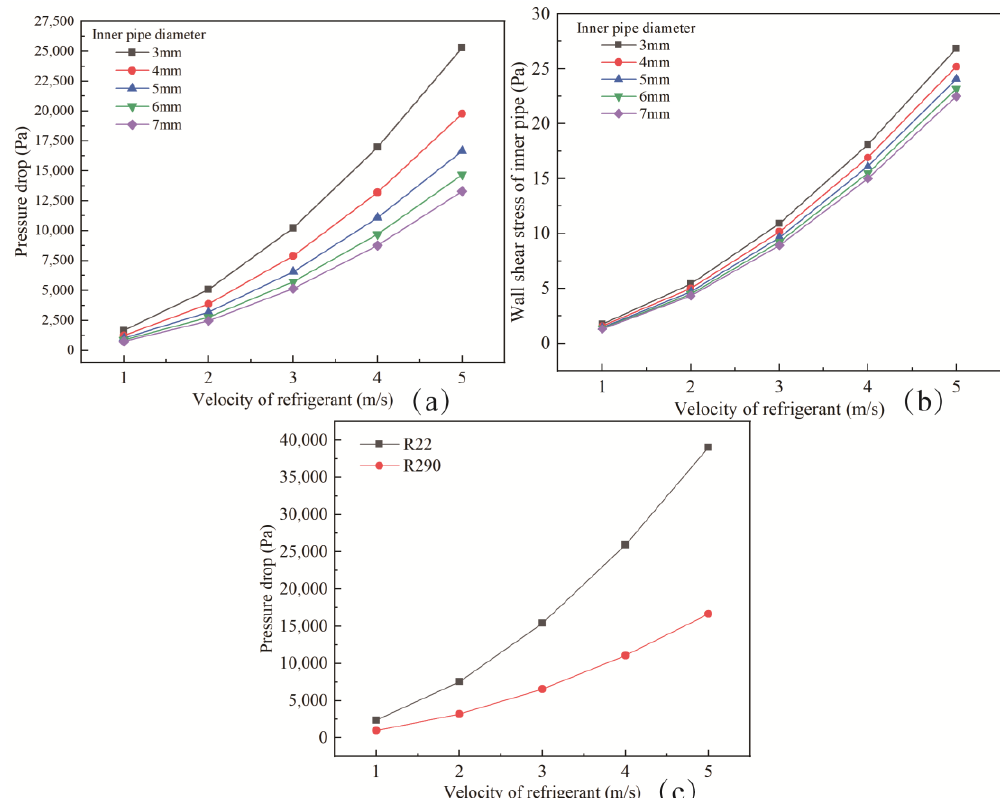
Figure 10. The impact of ( a ) refrigerant velocity on pressure drop, ( b ) wall shear stress of inner pipe and ( c ) pressure drop of R22 and R290 at different refrigerant velocities.